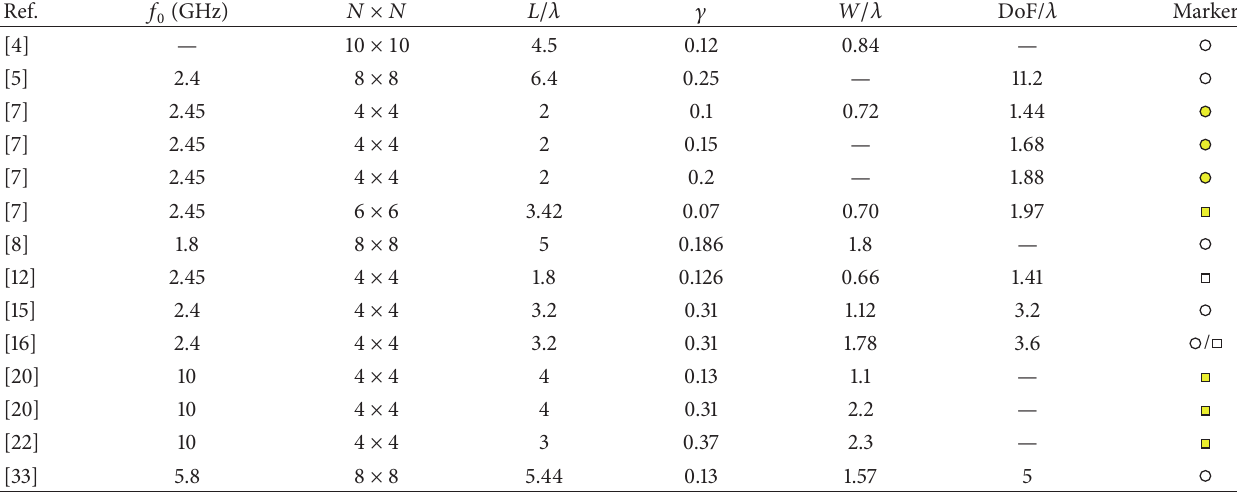
Table 1: 𝑁 × 𝑁 planar focused arrays: performance in terms of depth of focus (DoF) and − 3 dB spot width ( 𝑊 ).